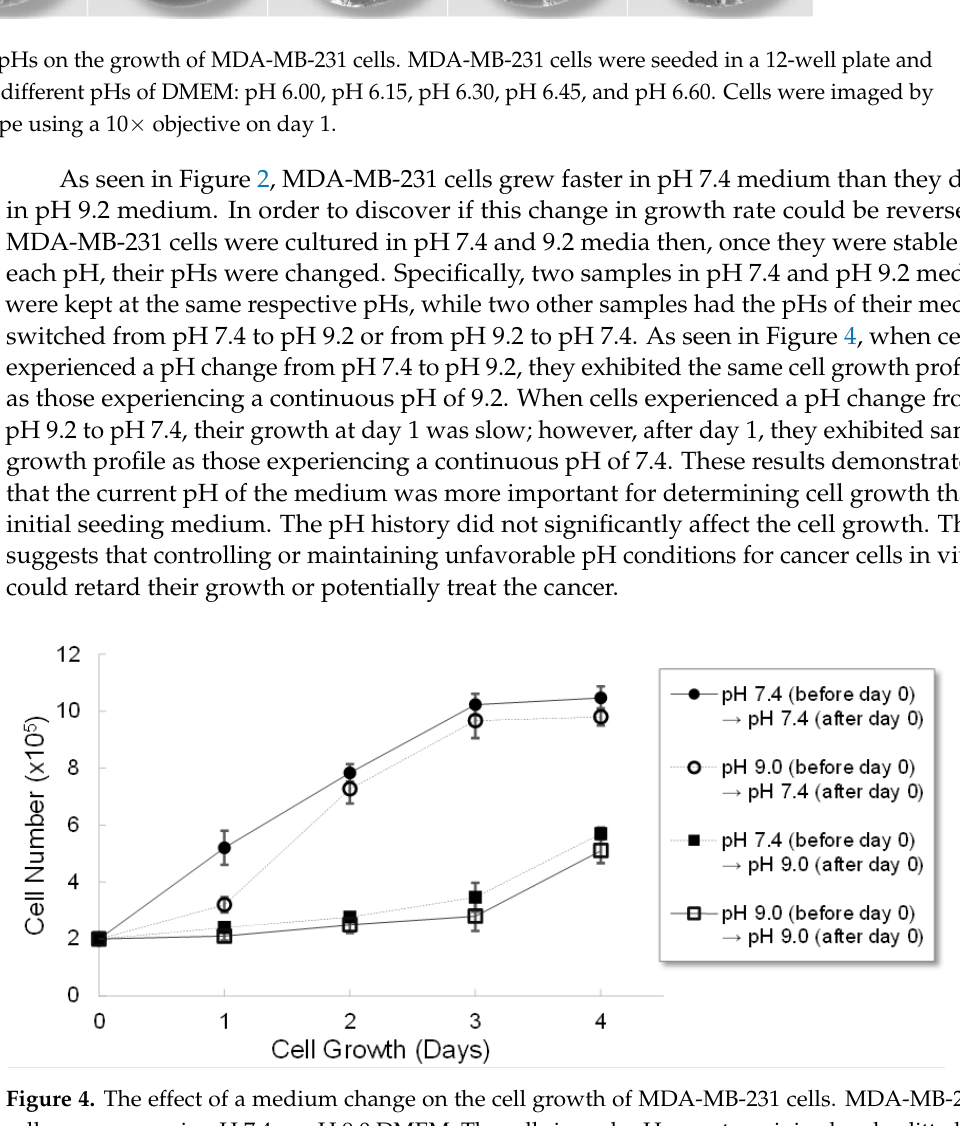
Figure 3. The effect of acid pHs on the growth of MDA-MB-231 cells. MDA-MB-231 cells were seeded in a 12-well plate and they were incubated at five different pHs of DMEM: pH 6.00, pH 6.15, pH 6.30, pH 6.45, and pH 6.60. Cells were imaged by an Olympus IX70 microscope using a 10× objective on day 1.